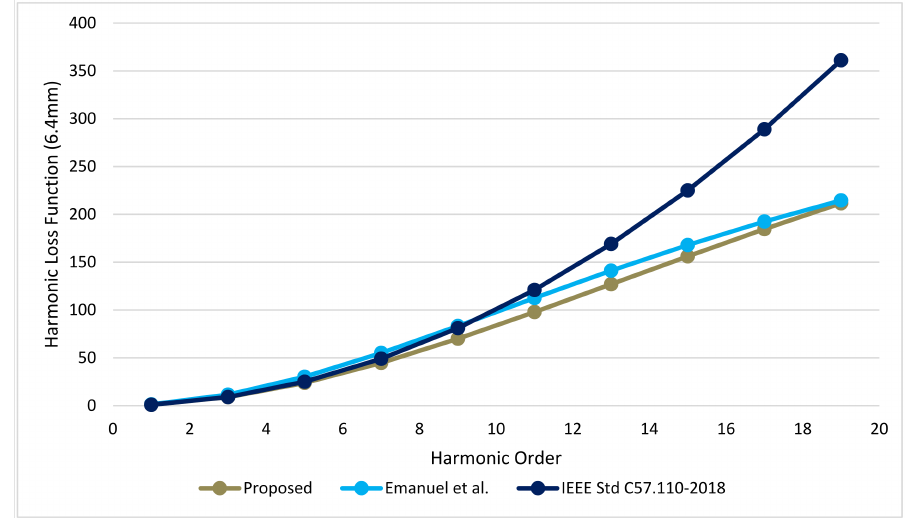
Figure 1. Comparison of the winding Eddy loss correction